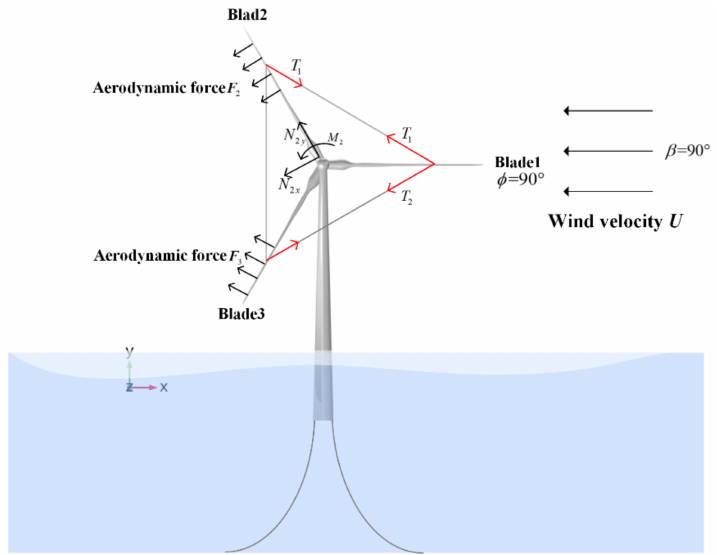
Figure 5. Diagram of static analysis on blades with